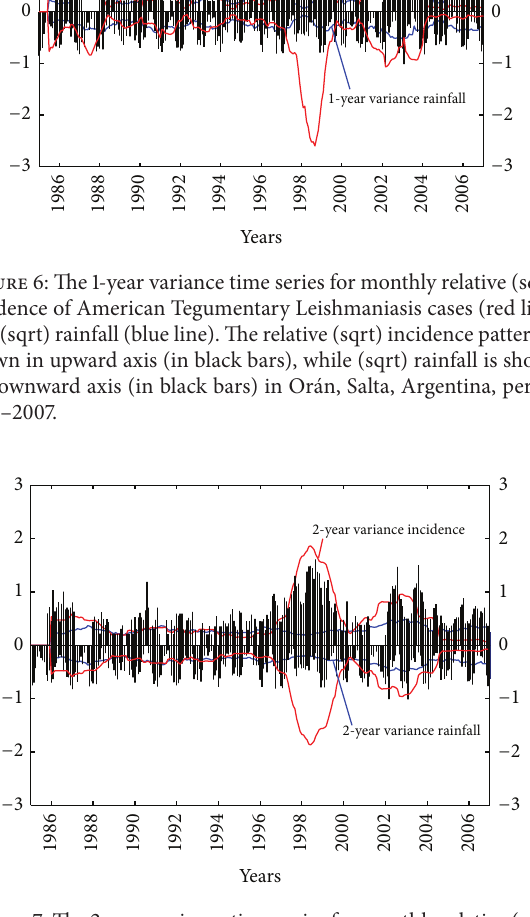
Figure 7: The 2-year variance time series for monthly relative (sqrt) incidence of American Tegumentary Leishmaniasis cases (red line) and rainfall (blue line) in Or´an, Salta, Argentina, period